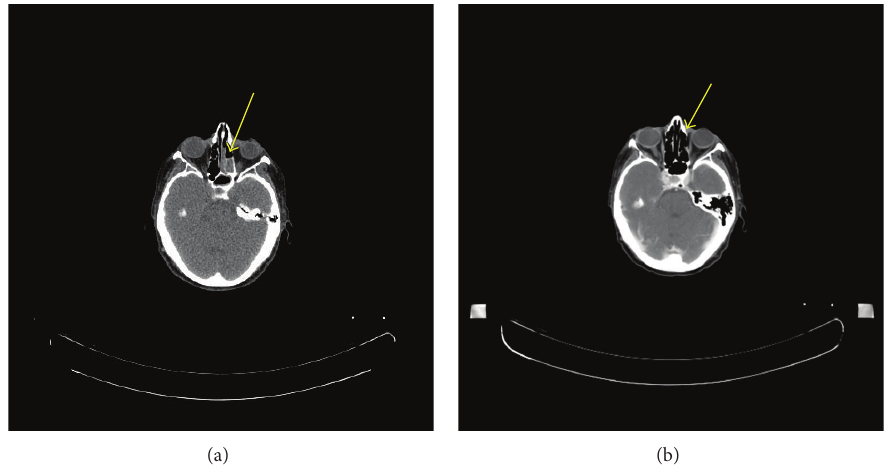
Figure 2: Images from computed tomography scanning prior to starting chemotherapy and after three cycles, showing resolution of left nasopharyngeal